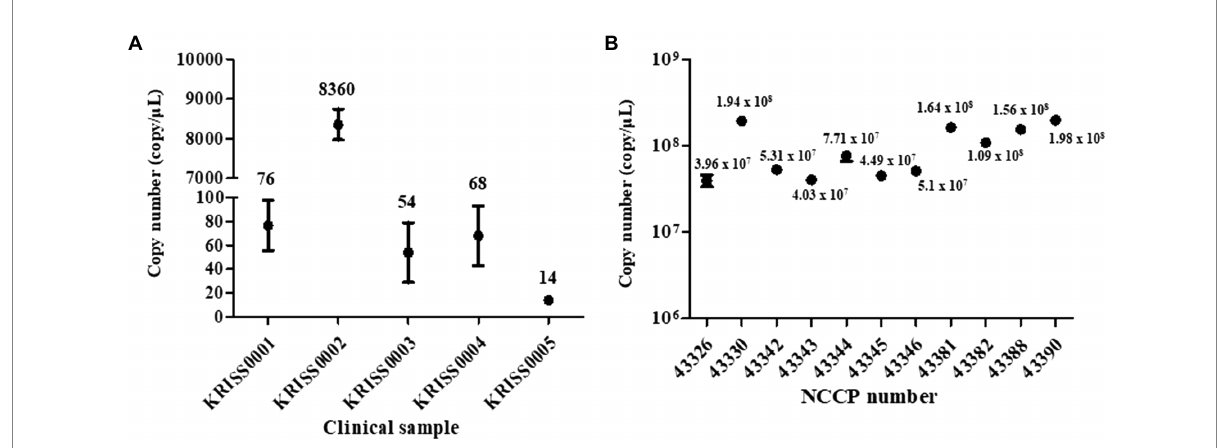
FIGURE 2 Quantification of SARS-CoV-2 RNA using a reverse transcription droplet digital PCR (RT-ddPCR). The copy numbers of SARS-CoV-2 RNA were measured RT-ddPCR assay using N gene targeting primer-probe sets. (A) The copy number of SARS-CoV-2 RNA in clinical samples. (B) The copy number of viral RNA in NCCP samples. The numbers of the above point and bars indicate mean copy numbers and standard